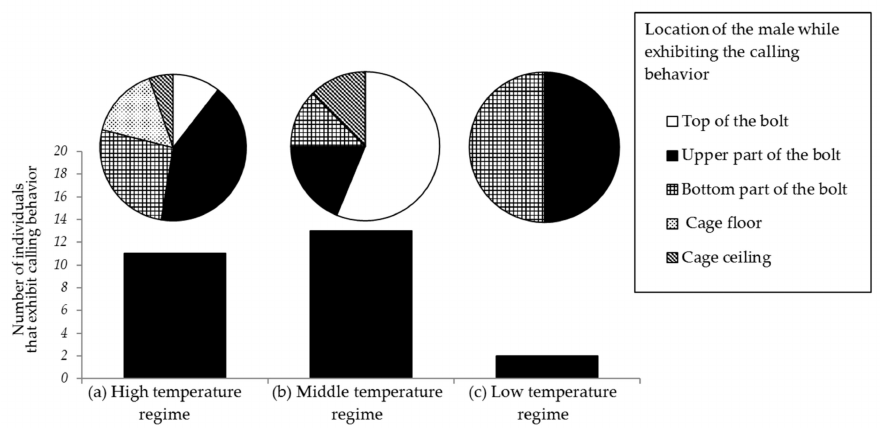
Figure 12. Numbers of trials in which the male Rosalia batesi exhibited calling behaviors. Experiments were conducted in a laboratory cage (150 × 150 × 150 mm) equipped with a Zelkova serrata bolt (80 mm in length, 40 mm in diameter) set perpendicularly on the floor, under three light and temperature regimes (high, middle, and low). The male beetles’ positions while exhibiting calling behaviors and their frequencies are shown in the pie